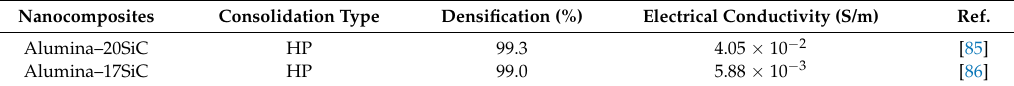
Table 5. Electrical conductivity of Al 2 O 3 –SiC nanocomposites.